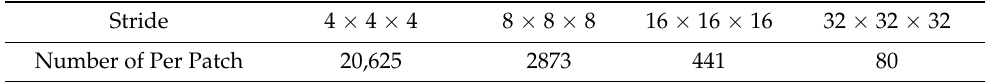
Table 1. Number of patches extracted in different strides during inference.